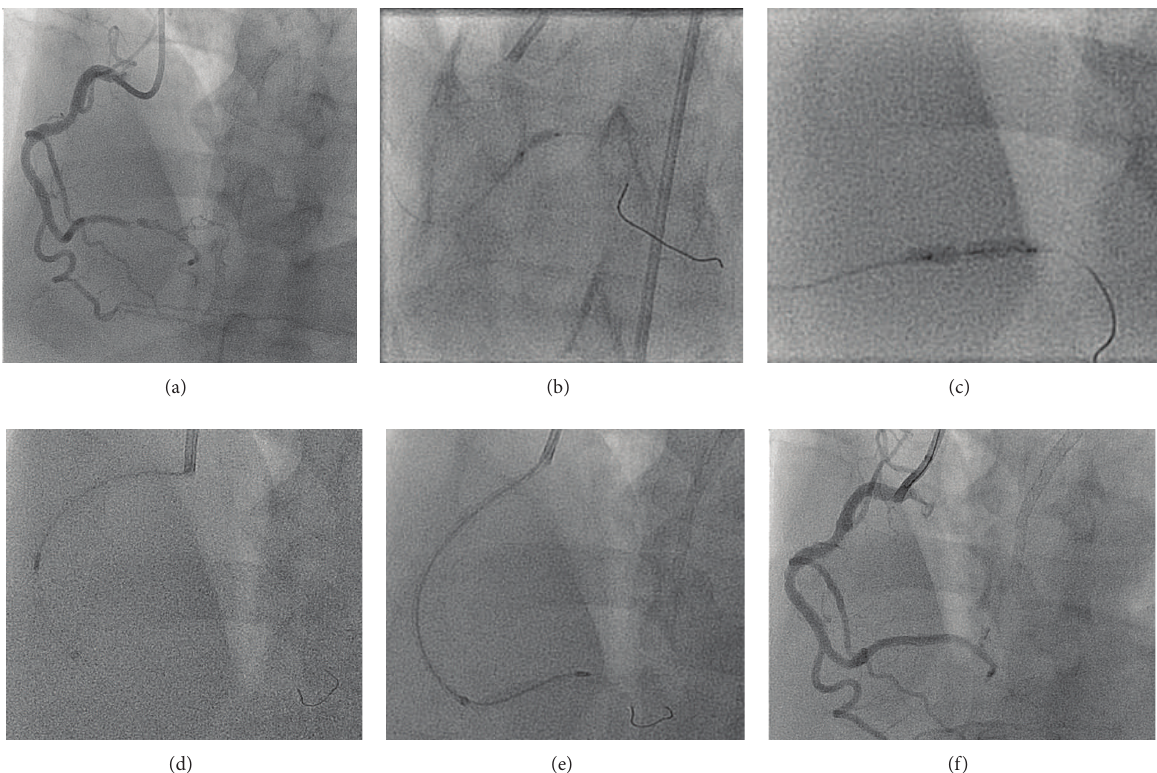
Figure 2: Rotablation of the distal RCA, assisted with the insertion of a 7 Fr. GuideLiner catheter. (a) Tortuous RCA with distal lesion and TIMI 2 flow. ((b) and (c)) Resistant lesion within distal RCA to noncompliant balloon expansion. (d) Advancement of a 1.25 mm rotablation burr through a 7 Fr. GuideLiner. (e) Rotablation of the distal RCA. (f) Final angiographic result after stenting and